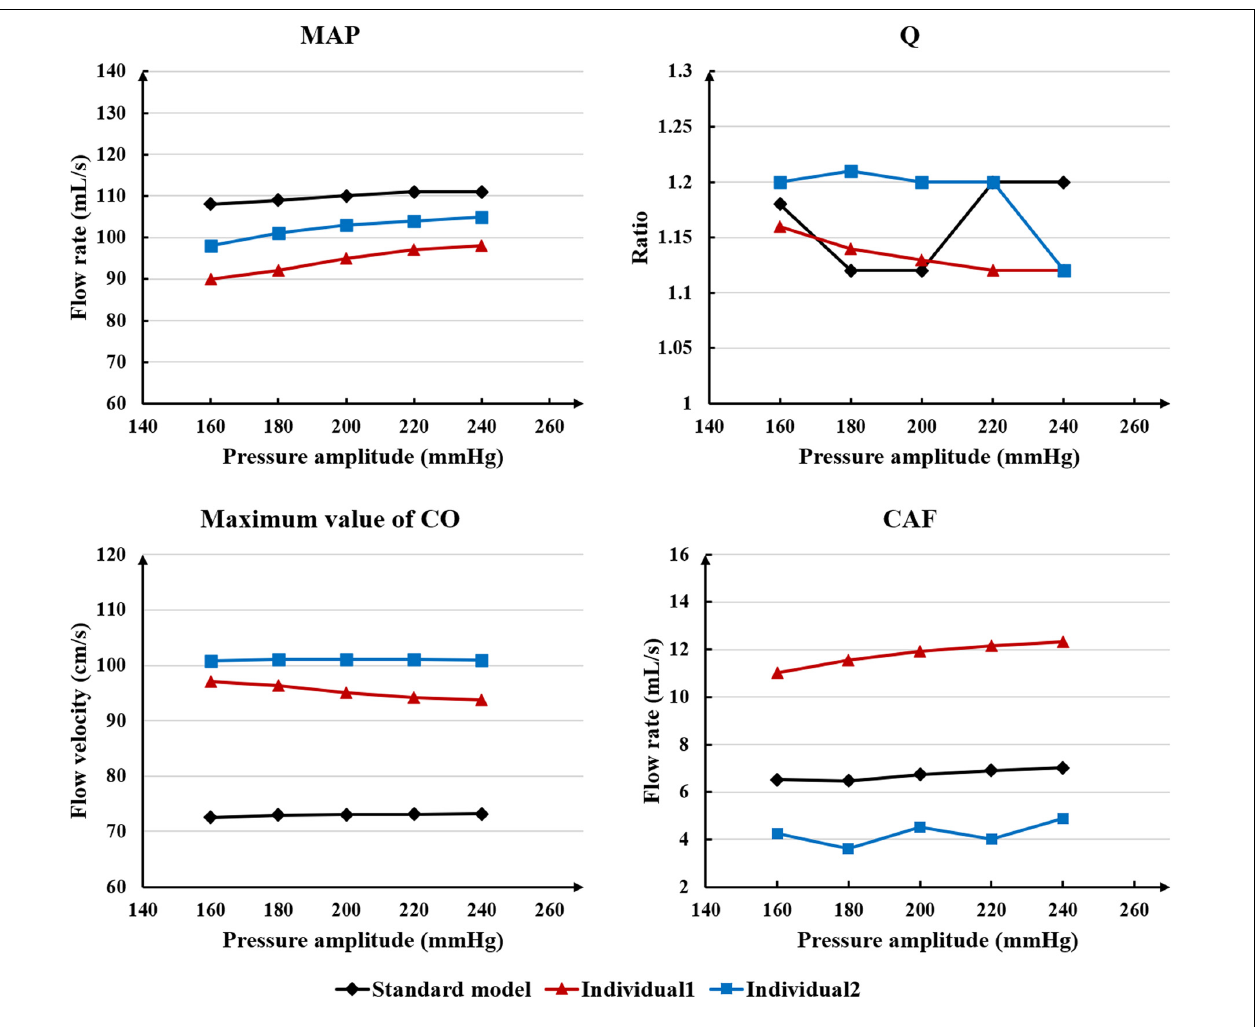
FIGURE 4 | The variations of acute hemodynamic effects under different pressure amplitudes. TABLE 1 | Compared with the resting state, the variations of MAP, Q, max CO velocity, and CAF of the three models under the pressure amplitude of approximately 200 mmHg, where IP is increased percentage.